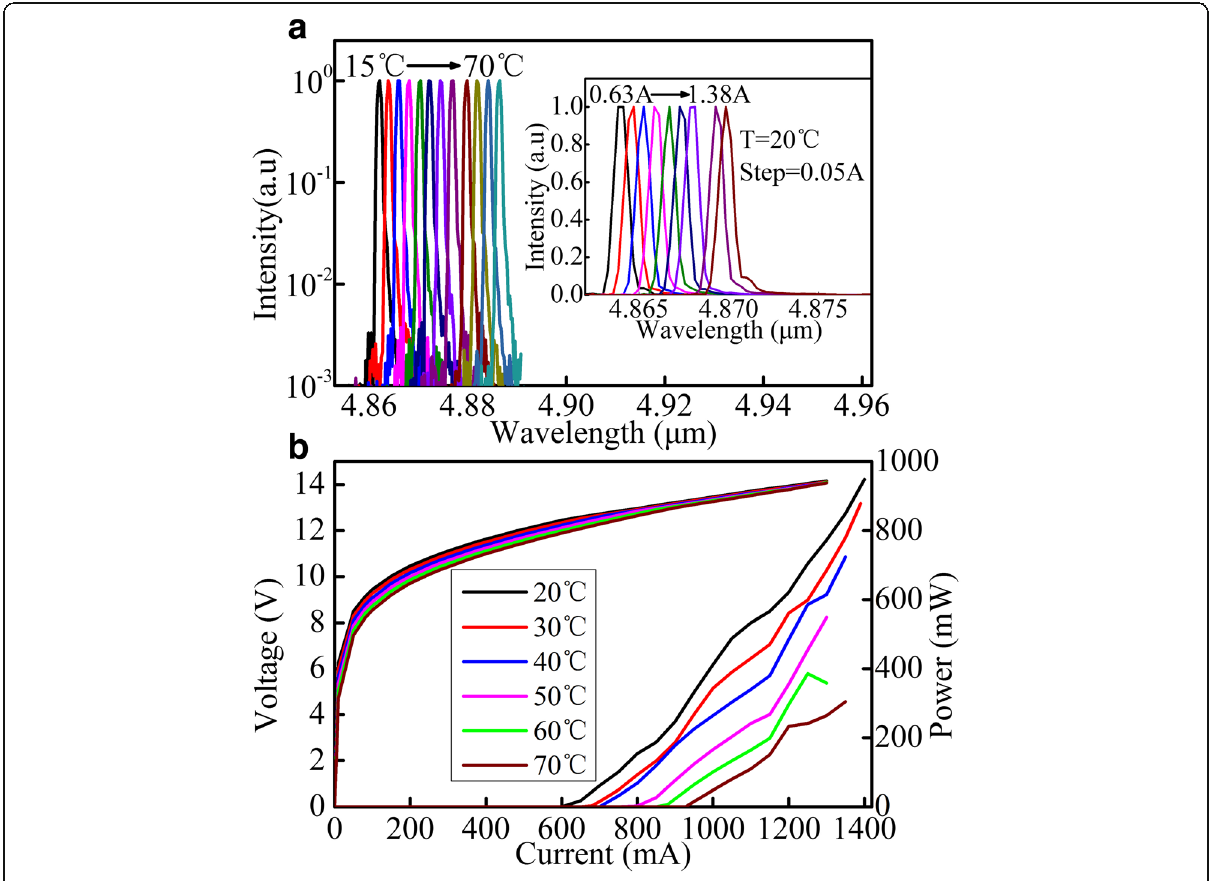
Fig. 6 a Single-mode CW emission spectra of a sampled grating DFB QCL with the cavity length of 6mm at currents around 1.1 × I th for different heat sink temperatures of 15 – 70°C. The inset shows CW emission spectra at different injection currents from 0.63 to 1.38 A with a step of 0.05 A at 20° C. b CW light – current – voltage (L – I – V) characteristics of sampled grating DFB QCL with the cavity length of 6mm at different